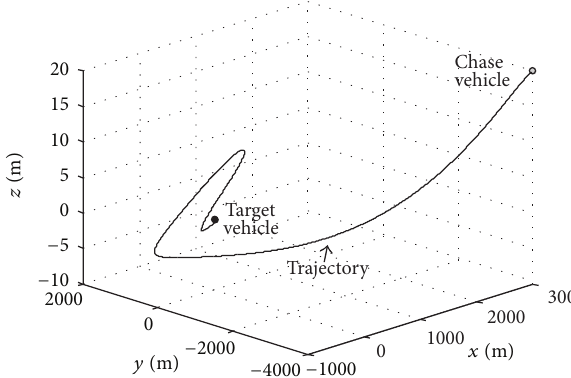
Figure 5: Rendezvous trajectory of the chase